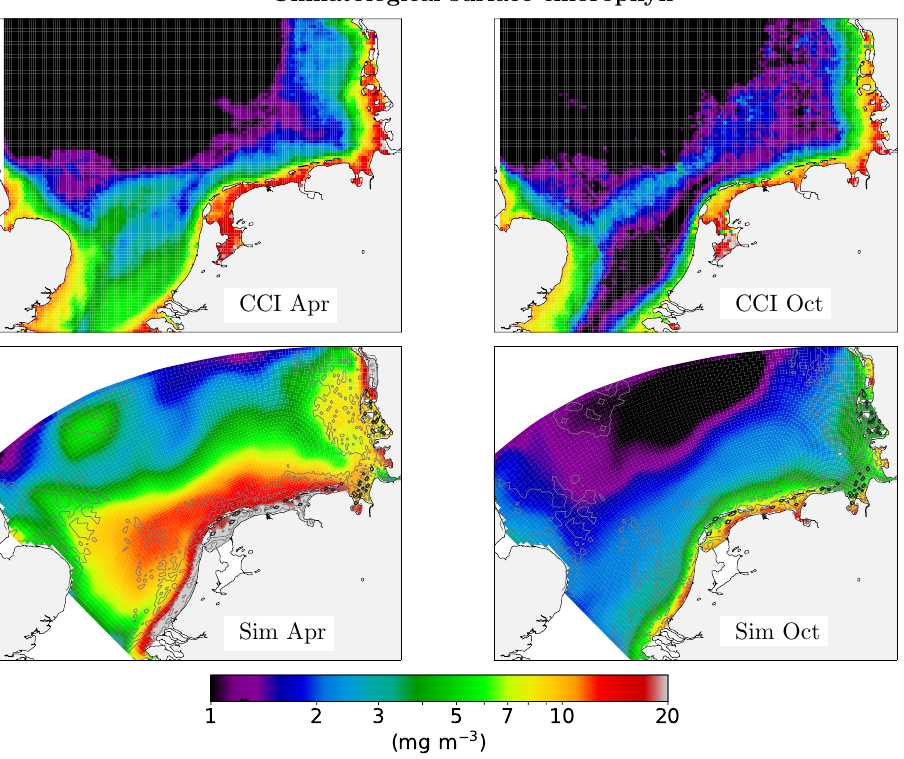
Figure 5. Climatological (2003–2013) observed and simulated surface chlorophyll for April and October. Observations are from the ESA-CCI Ocean Colour product, simulations results from the REF scenario with filtration. Further month and seasonal comparisons are available as supplementary material as Figures